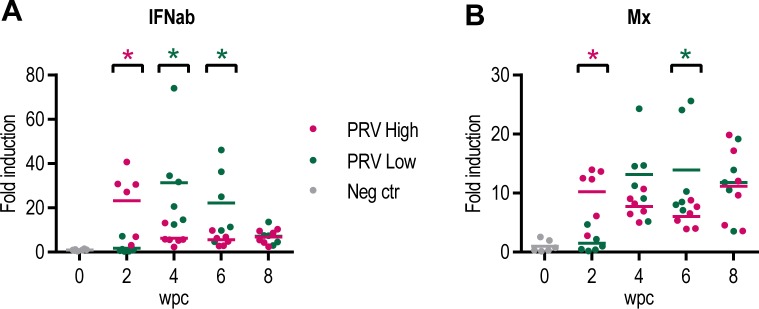
Expression of innate antiviral genes in blood cells in challenge experiment #2.Relative expression of type I interferon (IFNab) (A) and Mx (B) in controls (grey), the PRV-High (red) and the PRV-Low (green) group (n = 6). Target Ct values are normalized against the expression level of elongation factor (EF)1α, and fold induction relative to the mean level of control fish (0 wpc) is shown. Statistical analysis comparing PRV-High and PRV-Low was performed using Mann-Whitney test at each time point, *p < 0.05, asterisk color (red and green) indicate the significantly higher group.